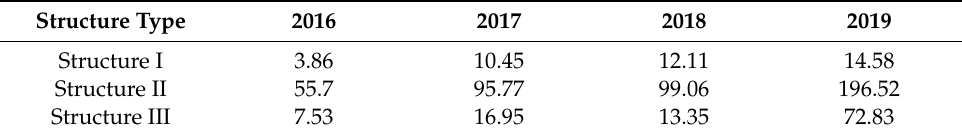
Table 10. Cumulative values of transverse fractures of di ff erent structures for four years (unit: